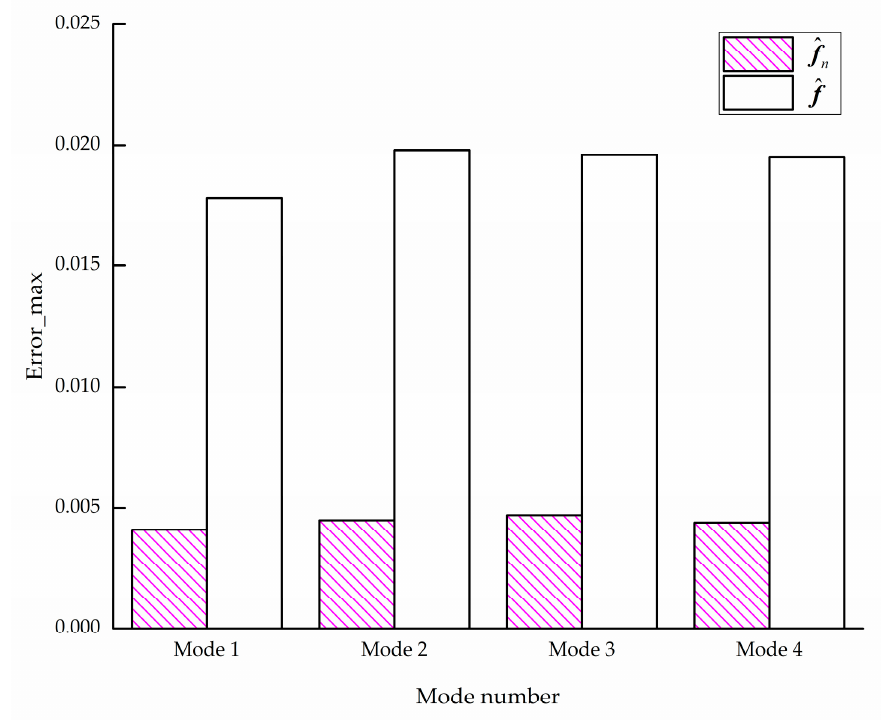
Figure 14. Maximum estimation error.